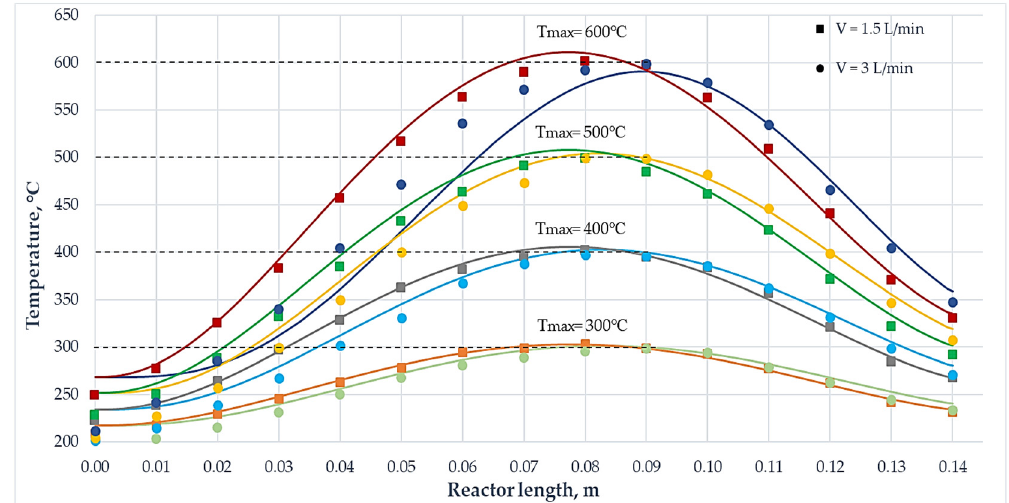
Figure 6. Comparison of the experimentally obtained temperature profiles along the reactor length at different temperature conditions and carrier gas flow rates with the profiles obtained during the calculation in COMSOL Multiphysics. Continuous lines show the calculated temperature values and experimental points (square points are taken at the carrier gas flow rate of 1.5 L/min, and round points at 3 L/min).